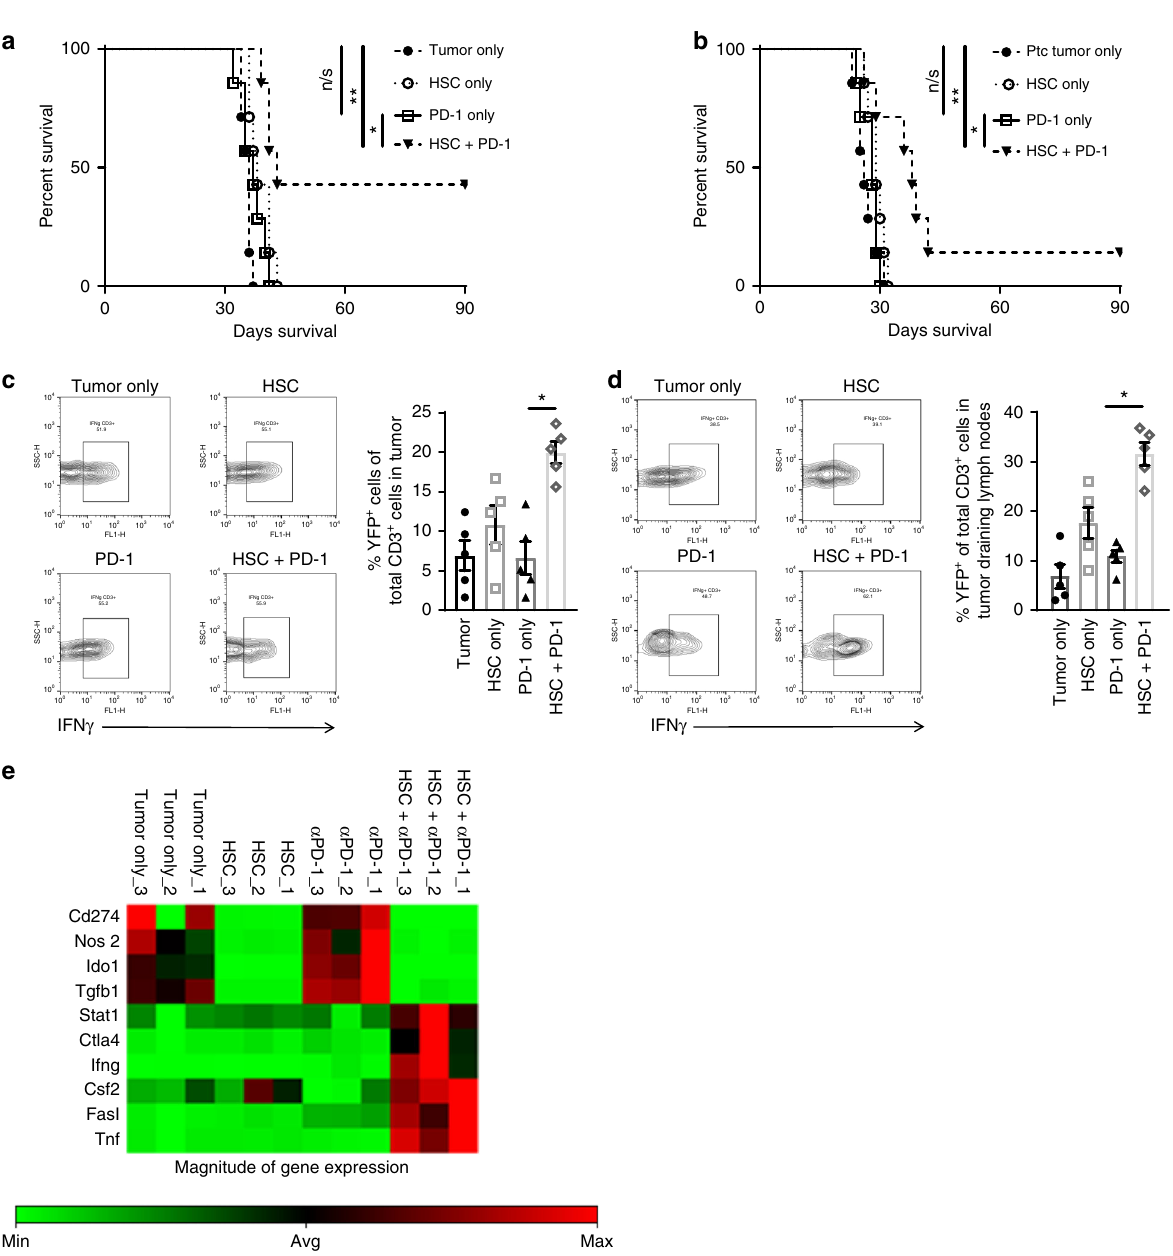
Fig. 1 HSC co-transfer increases overall survival in brain tumors refractory to PD-1. a Intracranial KR158B glioma was treated with either no